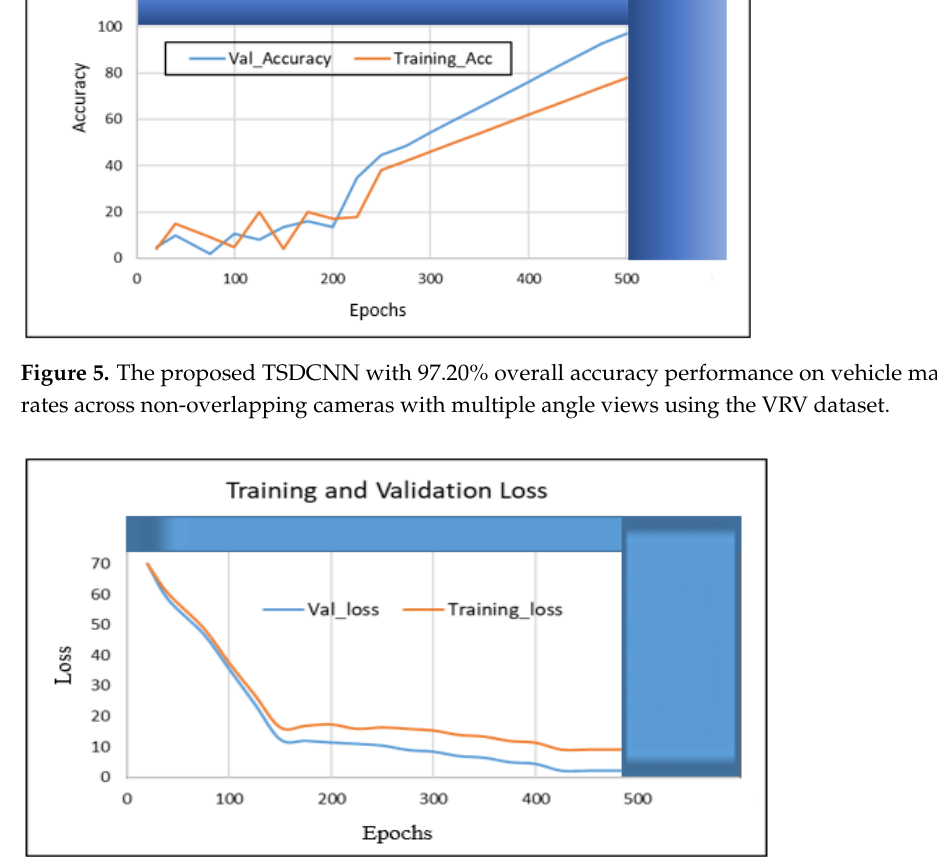
Figure 6. The proposed TSDCNN overall performance losses on vehicle matching rates across non-overlapping cameras with multiple angle views using the VRV dataset.